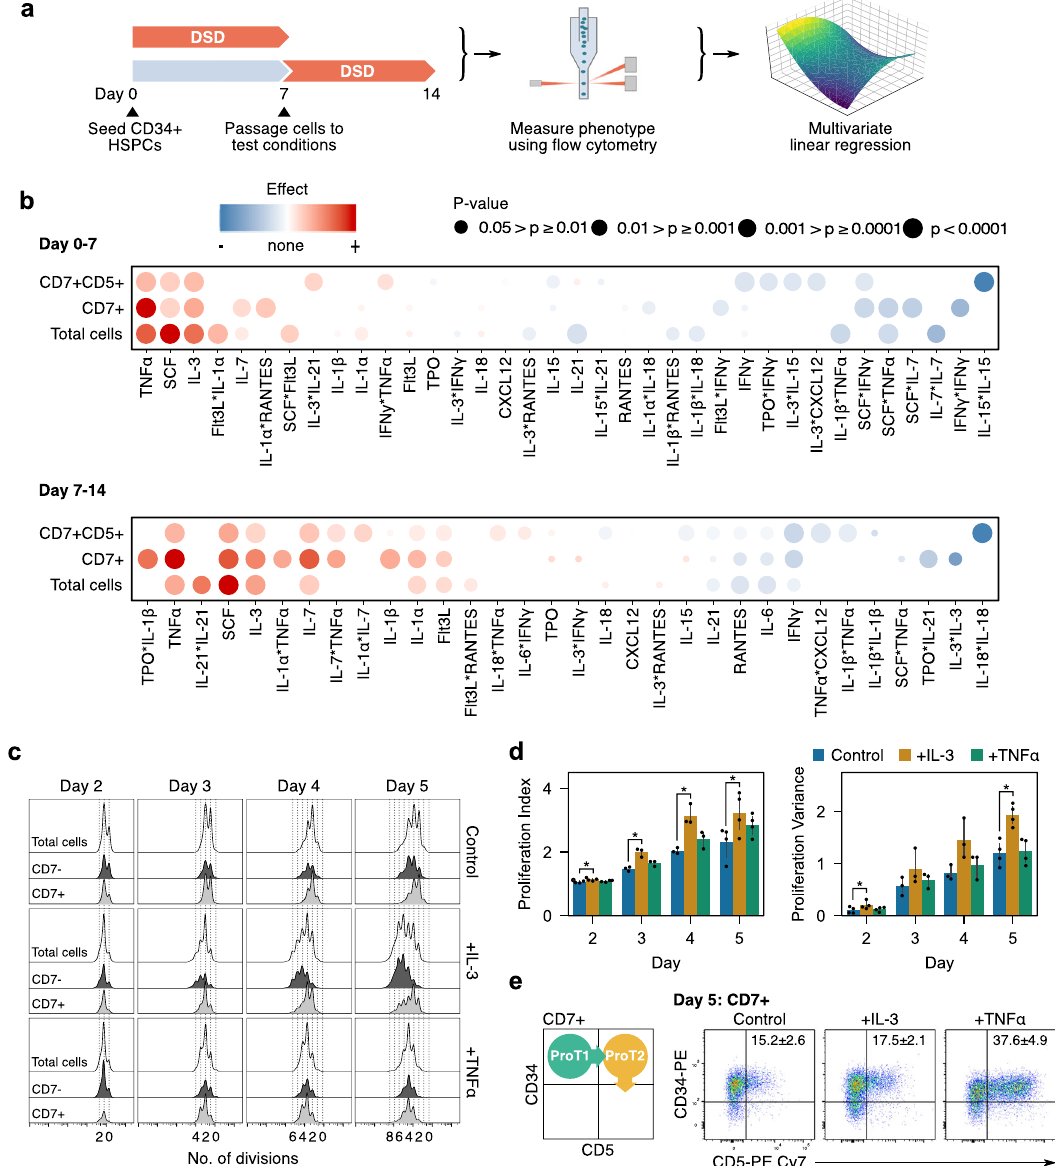
Fig. 1 Screening for cytokines that enhance proT-cell differentiation and expansion. a Summary of two-part screening experiment work fl ow. Cells were cultured in screening conditions from day 0 – 7 or cultured until day 7 and passaged at equal densities into test conditions and cultured until day 14. Cells from day 7 and 14 were harvested and analyzed using fl ow cytometry. The absolute count of each population of interest was measured and used to calculate a z -score relative to the 4F control. The z -scores were then used to fi t multivariate linear regression models. b Effect of cytokines on total cells, CD7 + lymphocytes, and CD7 + CD5 + cells. Red indicates an effect greater than the control condition while blue indicates an effect lesser than the control. The size of the circle indicates the signi fi cance of the effect in the regression model. From n = 2 independent UCB donors. c Histograms of CFSE stained cells showing the number of divisions of each cell on days 2 – 5. Separation of CD7 − and CD7 + histograms show differential responses to each cytokine. d Proliferation statistics from CFSE data. IL-3 treated cells had a larger proliferative index indicating that they underwent, on average, more divisions than the control group. They also had a signi fi cantly larger proliferative indicating that some cells responded much stronger to IL-3 than others. * p < 0.05 relative to the control on each day. e All groups transitioned through a proT1 to proT2 phenotype as expected during T-cell development. Results are mean ± standard error from n = 4 independent UCB